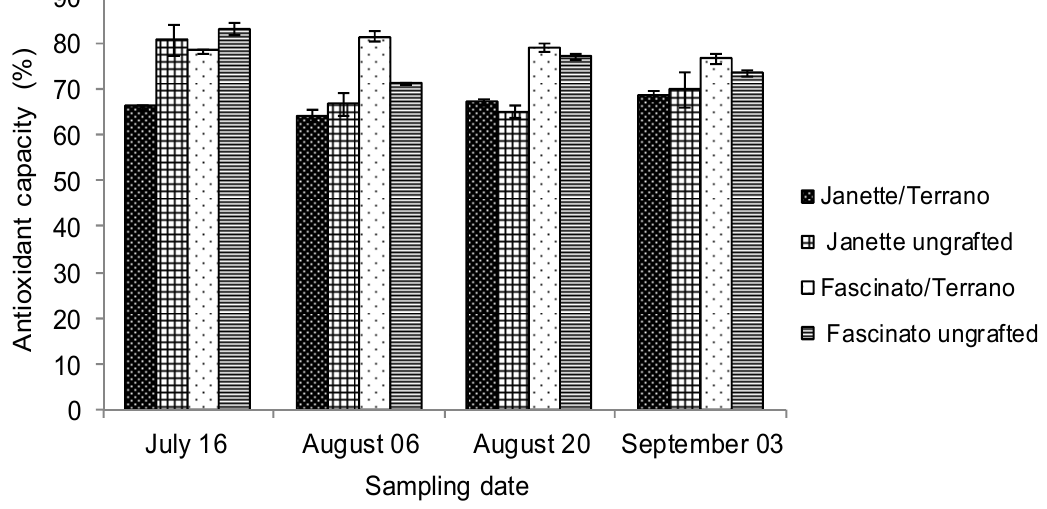
Figure 5. Antioxidant capacity of two bell pepper varieties grafted and